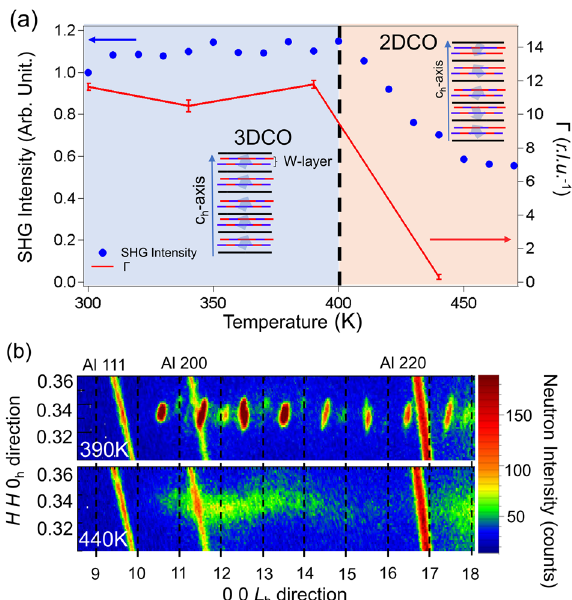
Figure 3. ( a ) Temperature dependence of the SHG signal ( I SH , blue) and correlation length of the charge order ( Γ , red), estimated from the 1/3 1/3 13.5 h peak width along the 0 0 L h direction. The dotted black line at 400 K represents 3-dimensional charge order transition temperature (T CO3D ). The insets labeled 3DCO and 2DCO represent 3-dimensional charge order and 2-dimensional charge order, respectively. ( b ) Reciprocal lattice space mapping of the superlattice diffraction near 1/3 1/3 L h in stoichiometric YbFe 2 O 4 at 390 K (top) and 440 K (bottom). The streaks labeled Al 111, Al 200, and Al 220 are due to diffraction from the sample holder. The colors encode the neutron intensity, with blue for low intensity and red for high